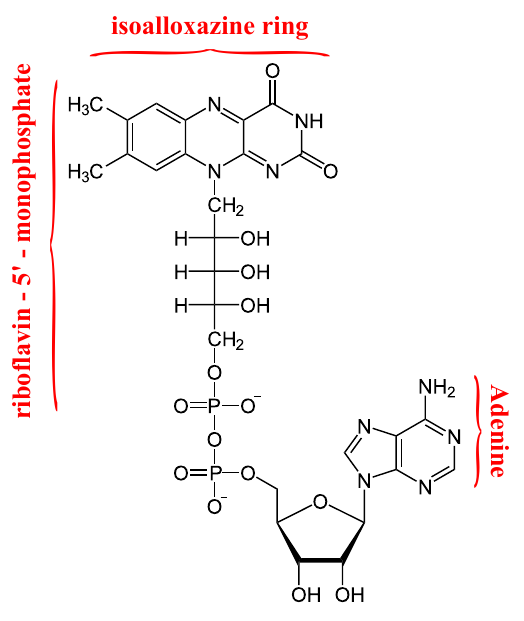
Figure 1. Structural formula of flavin adenine dinucleotide ( FAD